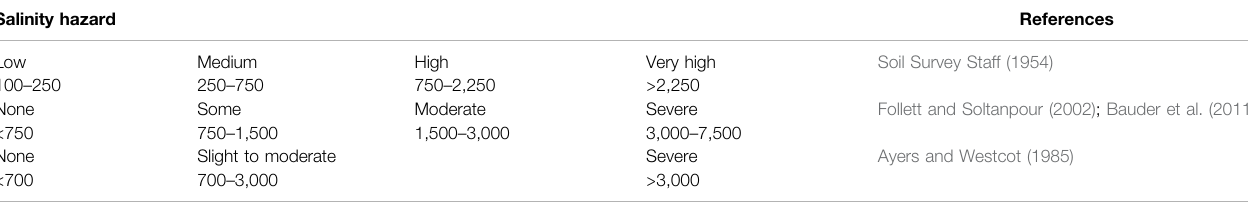
TABLE 3 | Salinity thresholds (in µS/cm) for different irrigation water qualities. Salinity